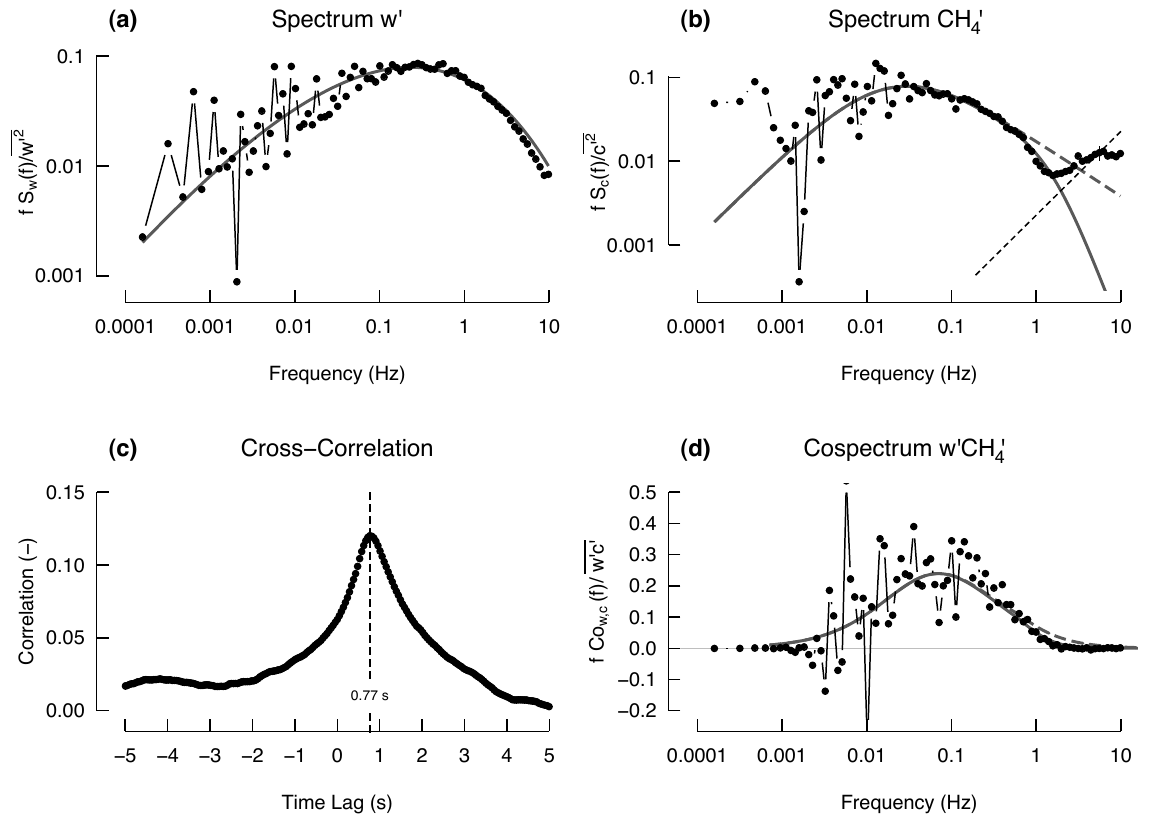
Fig. 1. Example spectra of (a) vertical wind speed w and (b) CH 4 concentration c , (c) time lag between w and c , and (d) cospectrum of CH 4 flux over Lake Wohlensee. The data used were collected during 1.75h (217 records) between 18:00 and 19:45 on 21 July 2008 with a mean horizontal wind speed of 1.5ms − 1 and wind direction 284 ◦ . Spectra and cospectrum were bandwidth averaged using 100 bands of equal spacing on the log frequency axis. Idealized curves are shown in gray. Dashed gray lines in (b) and (d) are idealized curves for an ideal system without high-frequency damping losses, and black dashed line in (b) shows white noise level of CH 4